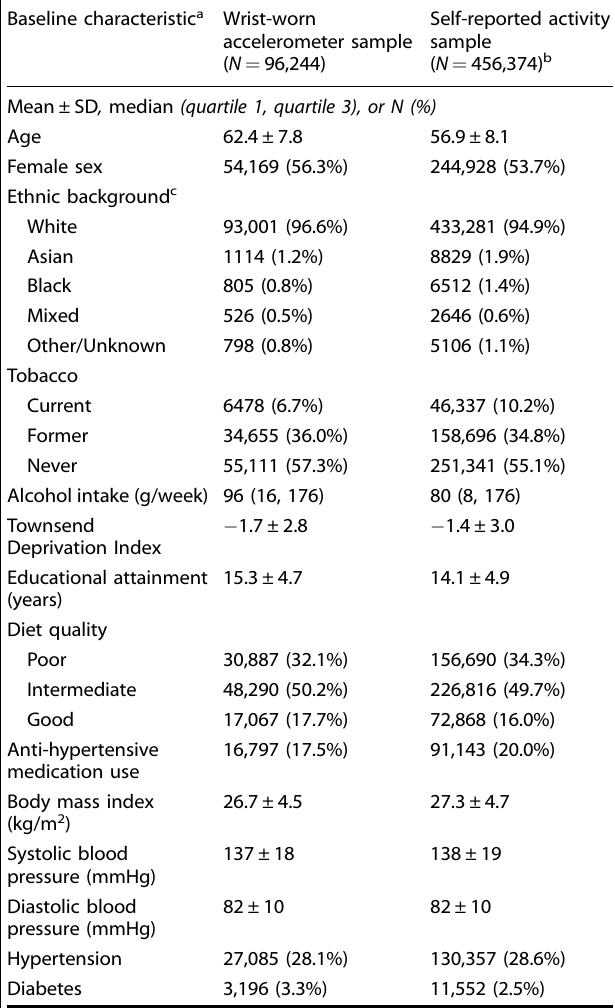
Table 1. Baseline characteristics of study